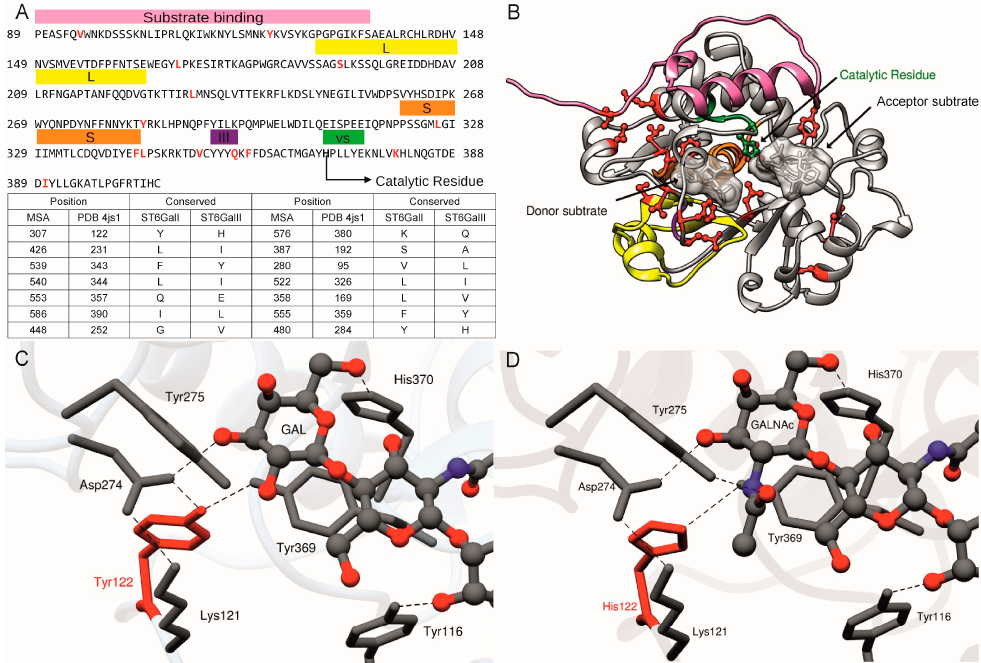
Figure 9. Sequence and structural mapping of SDPs between ST6GalI and ST6GalII. ( A ) The human protein sequence of ST6Gal I corresponding to PDB 4js2 is shown as a reference sequence, at the top of the panel. The functionally important regions are indicated with colored boxes and 14 SDPs of type II are highlighted in red. SDP prediction between ST6Gal I and ST6Gal II was carried out using SPEER server [82] using the MSA described previously that was composed by 48 sequences belonging to ST6Gal I and 53 of ST6Gal II (Data S3). A total of 78 and 69 SDPs of Type I and Type II respectively were predicted (Data S4). At the bottom of the panel, a table is shown with the 14 Type II SDPs with a reliable score. The first column indicates the position in the multiple sequence alignment (MSA), the second column the position in the reference sequence, the 3rd and 4th columns indicate the conserved amino acid in the ST6Gal I and ST6Gal II sequences, respectively. The SDPs are sorted according to the predictive score, from higher to lower; from top to bottom and from left to right; ( B ) The functionally important regions and SDPs are shown in the structure of the reference human ST6Gal I sequence. In addition, the surfaces of the substrates are shown; ( C ) Close-up of the glycan binding site of ST6Gal I , hydrogen bonds are denoted by dashed lines; ( D ) Close-up of the glycan binding site, where the Gal was modeled to GalNAc to represent ST6Gal II binding site.